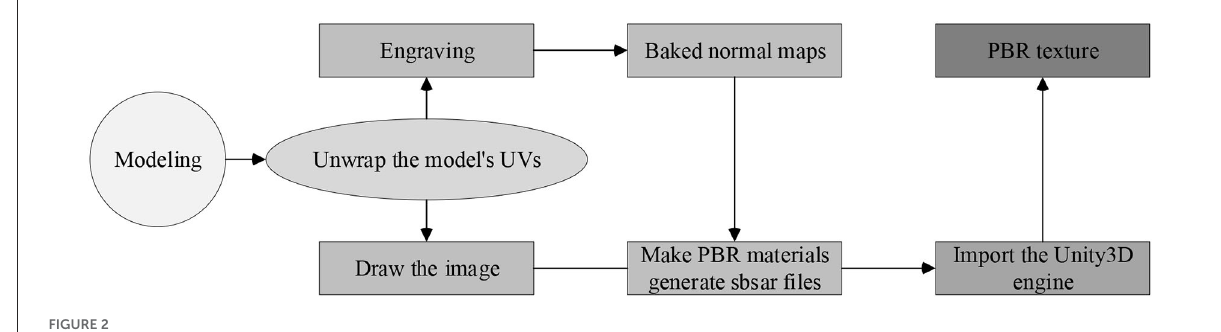
FIGURE2 Workflow for processing into PBR materials.